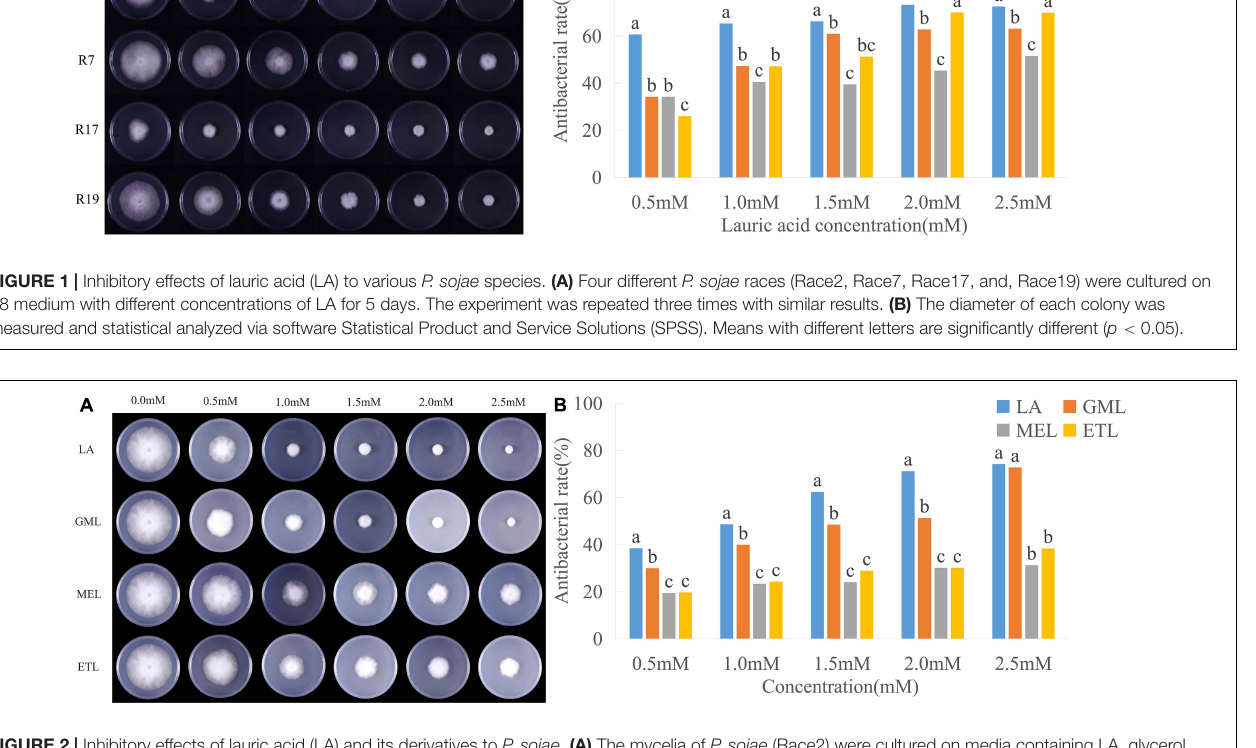
distortions, bending, and nodules than those in the control